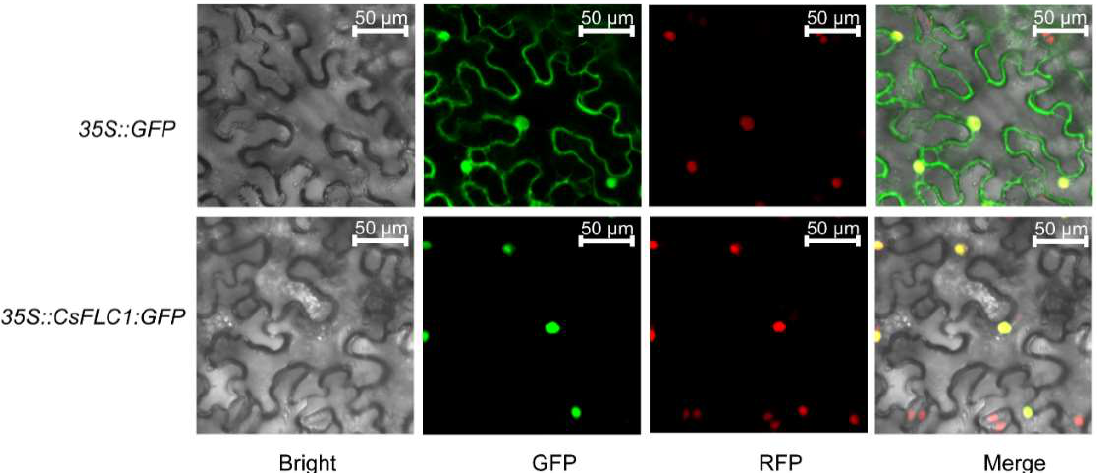
Figure 2. Subcellular location of CsFLC1 in Nicotiana Benthamiana . GFP: green fluorescent protein; RFP: red fluorescent protein; bar: 50 µm.